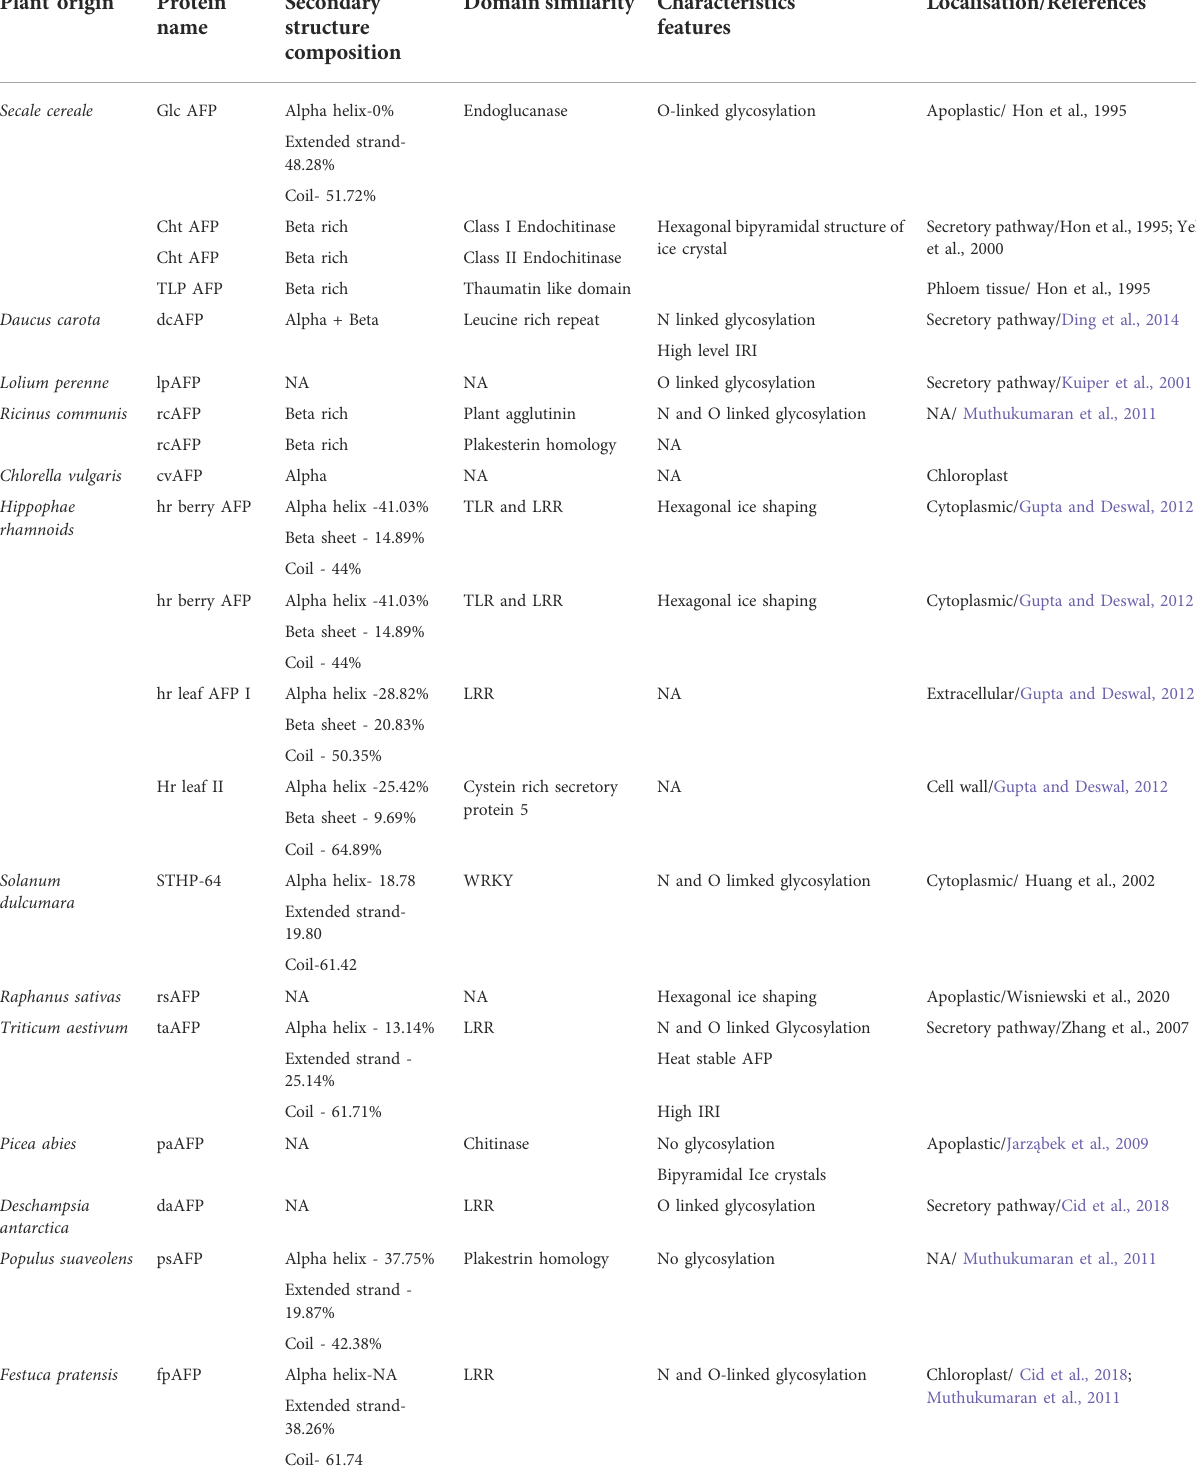
TABLE 1 List of antifreez proteins reported in